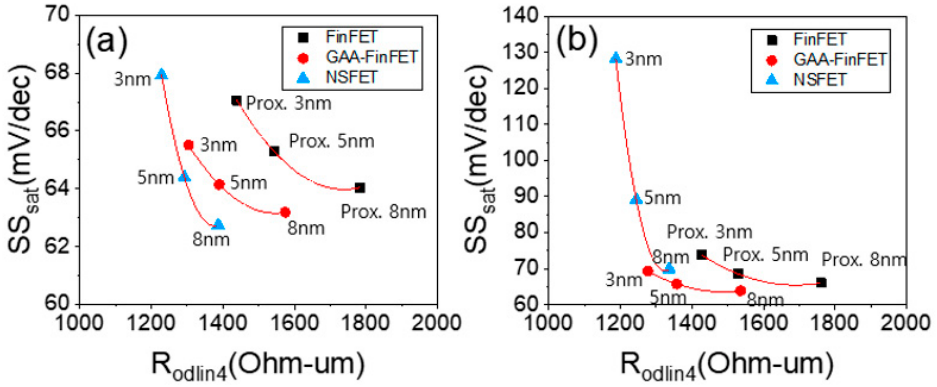
Figure 8. Trade-off between SS sat and R odlin4 at three values of proximity (i.e., 8 nm, 5 nm, and 3 nm) in each device. The doping concentration in the sub-channel region was set to ( a ) 1 × 10 18 cm − 3 and ( b ) 5 × 10 17 cm − 3 . ( b ) 5 × 10 17 cm − 3